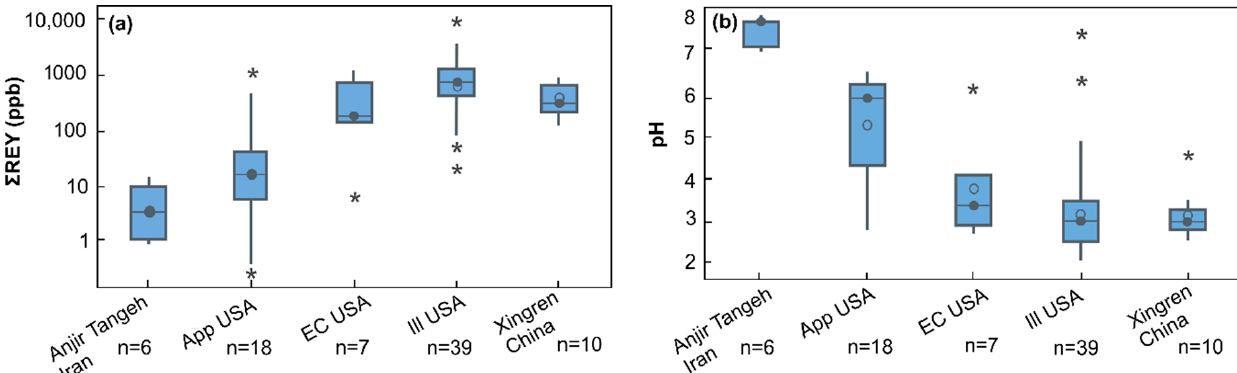
Figure 3. Boxplots of ( a ) Σ REY concentrations and ( b ) pH values for coal mine drainage from different coal mines [42–44,47,48], (*: outlier values) .